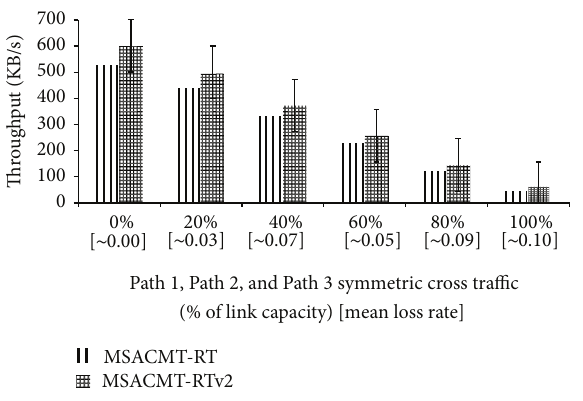
Figure 6: MSACMT-RT versus MSACMT-RTv2 during symmetric loss.